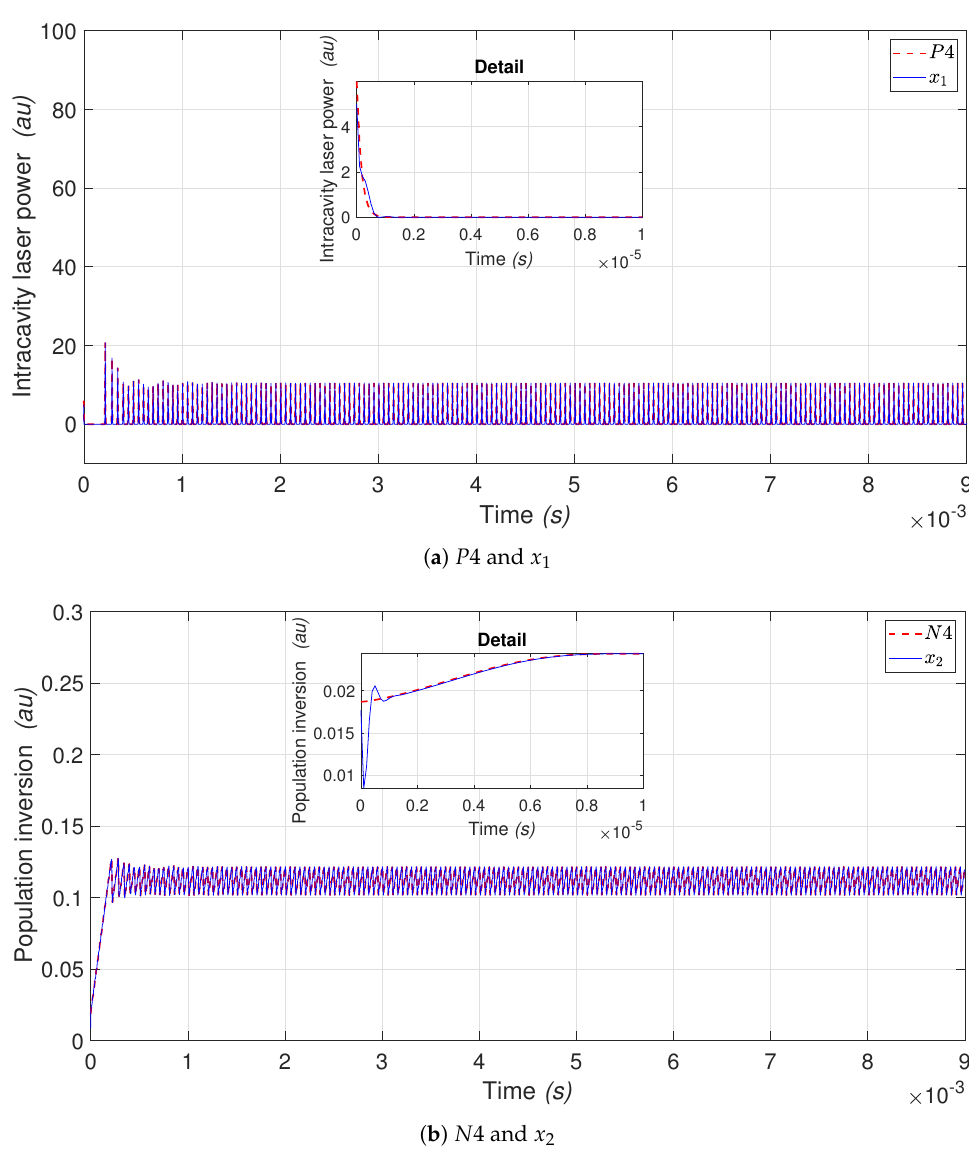
Figure 6. ( a ) Intracavity laser power P 4 and neural identification x 1 behavior. ( b ) Population inversion N 4 and neural identification x 2